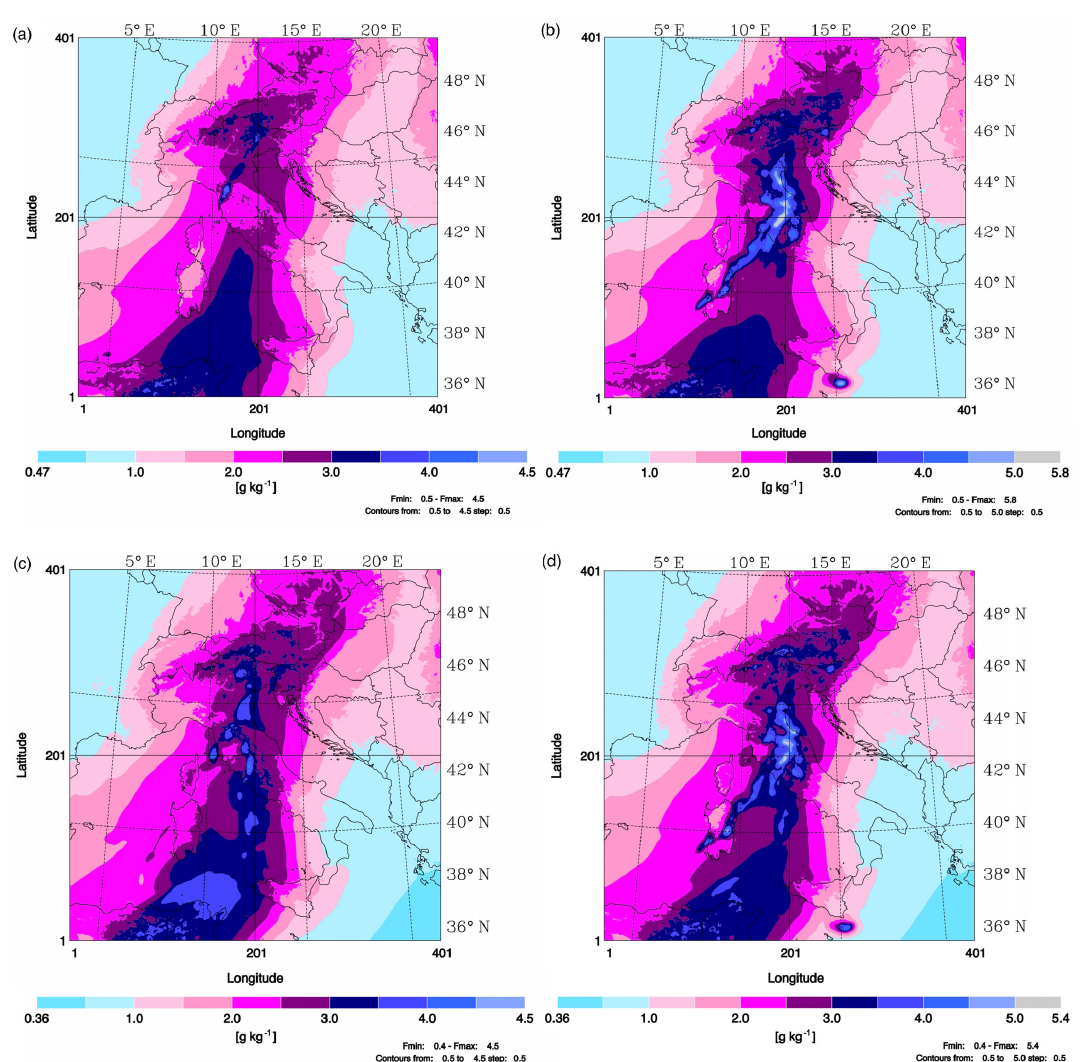
Figure 18. Water vapour mixing ratio averaged between 3 and 10km at 06:00UTC on 10 September 2017 for (a) CTRL, (b) RAD, (c) LIGHT, and (d)